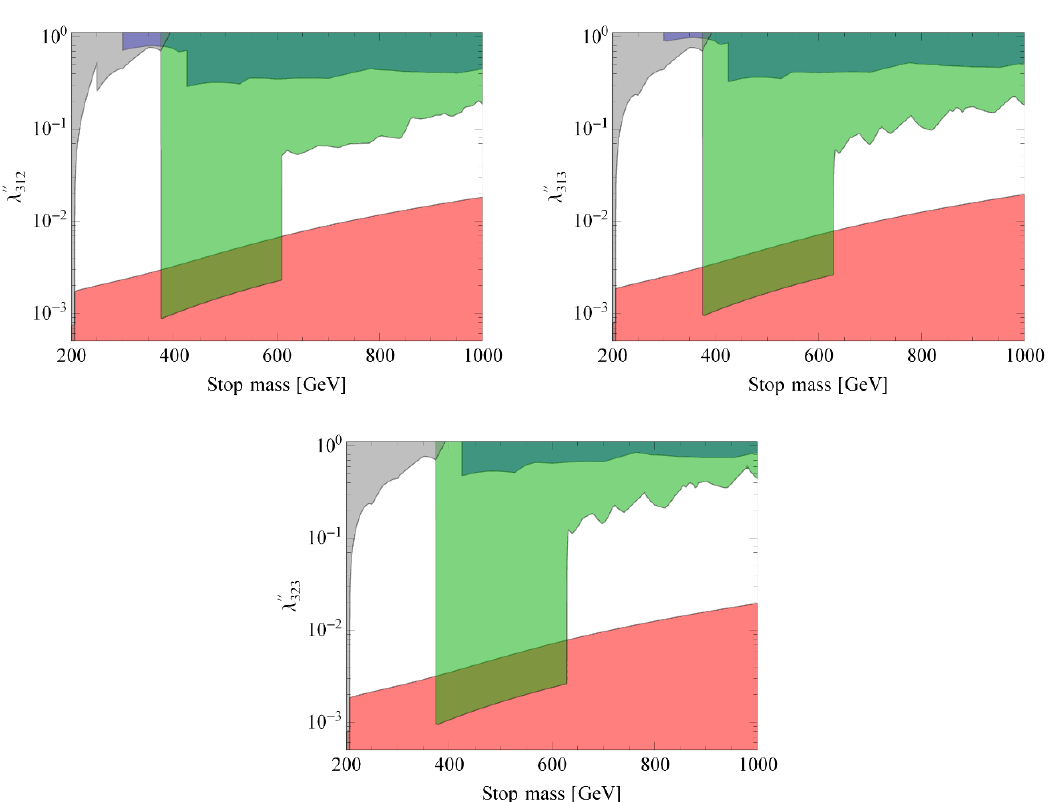
Figure 13. Exclusion plots for a 200 GeV Higgsino-up neutralino LSP with the U(1) R symmetry broken. The grey region on the left side of the plots ( m ~ searches. Next, consider the middle region of the plots. Starting from large (cid:21) 00 working downwards, the blue region is excluded by dijet searches, the green region is excluded by neutralino LSP searches and the red region is excluded by displaced vertices